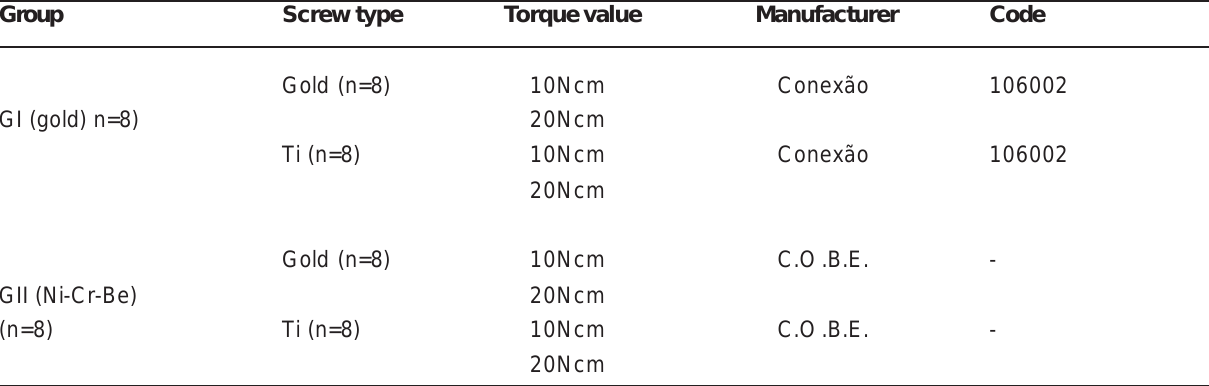
TABLE 1- Cylinder, screw and torque values used in this study